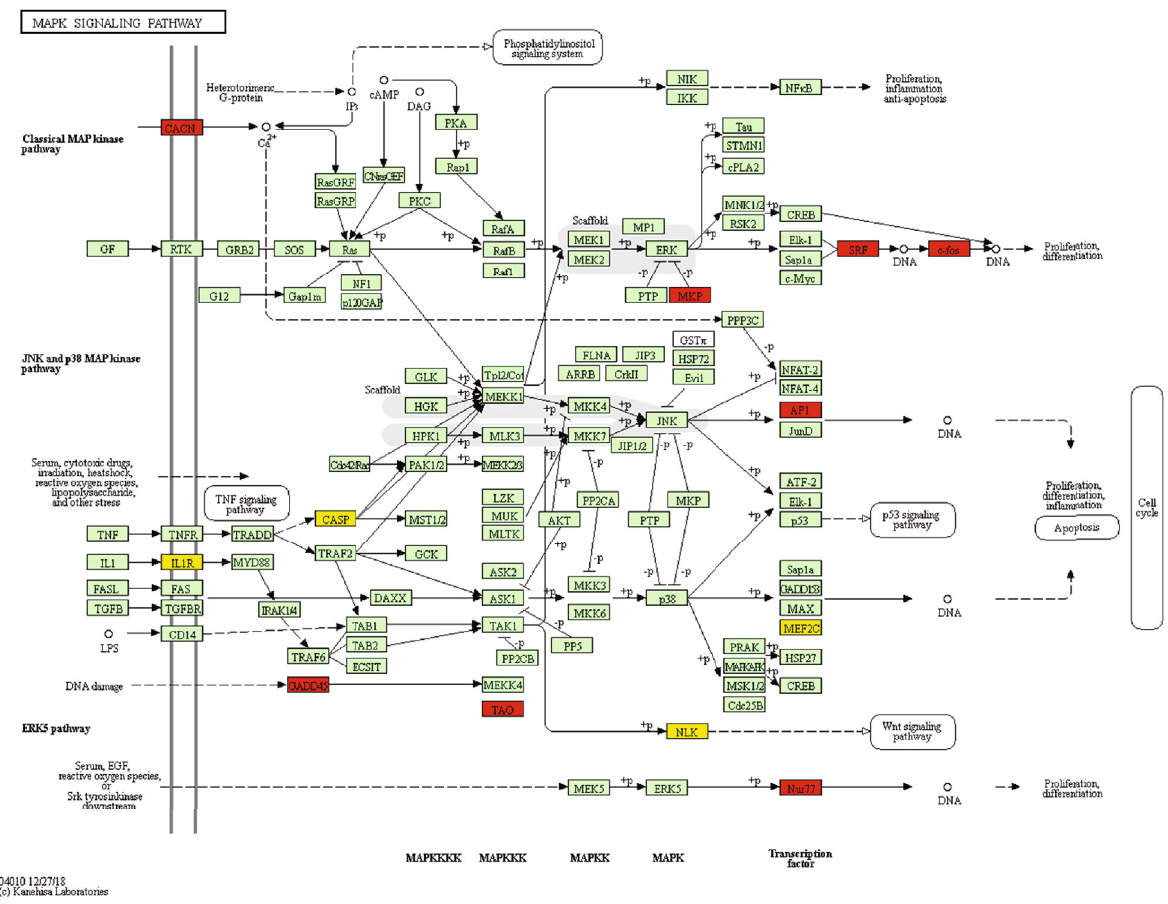
Figure 7: The most correlated MAPK signaling pathway enriched in KEGG mapper. All green boxes represent targets of MAPK signaling pathway in human. 8 red boxes (GADD45(GADD45G), MKP (DUSP1), c-fos (FOS), AP1 (FOS), Nur77(NR4A11), SRF, CACN (CACNA1H), and TAO(TAOK2)) represent upregulated targets. 4 yellow boxes (IL1R(IL1RAP), MEF2C, NLK, and CASP(CASP3)) represent downregulated targets.